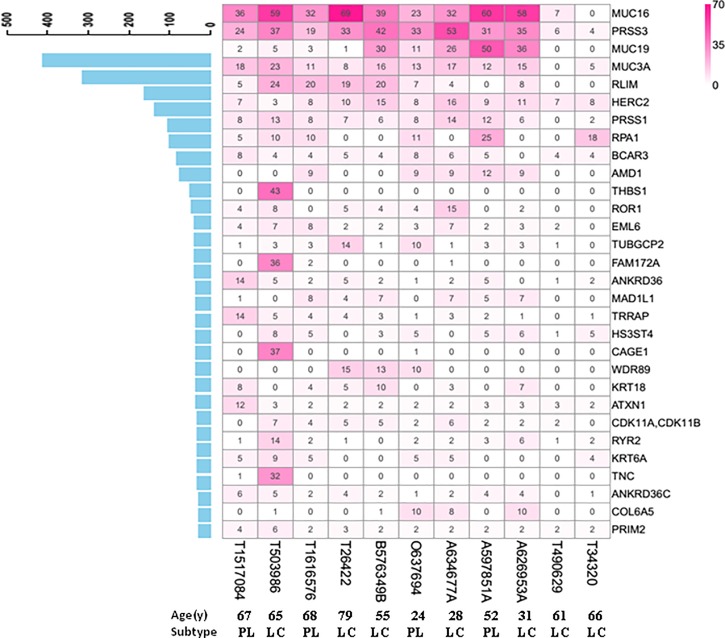
The 30 most commonly mutated genes from selected variants in EBV+ DLBCL identified by whole-exome sequencing.Based on the total number of all mutation loci within one somatic mutated gene in a detected region (exonic region, intronic region, intergenic region, UTR, and other regions), the top 5 most frequently mutated genes were MUC16, PRSS3, MUC19, MUC3A, and RLIM in decreasing order.